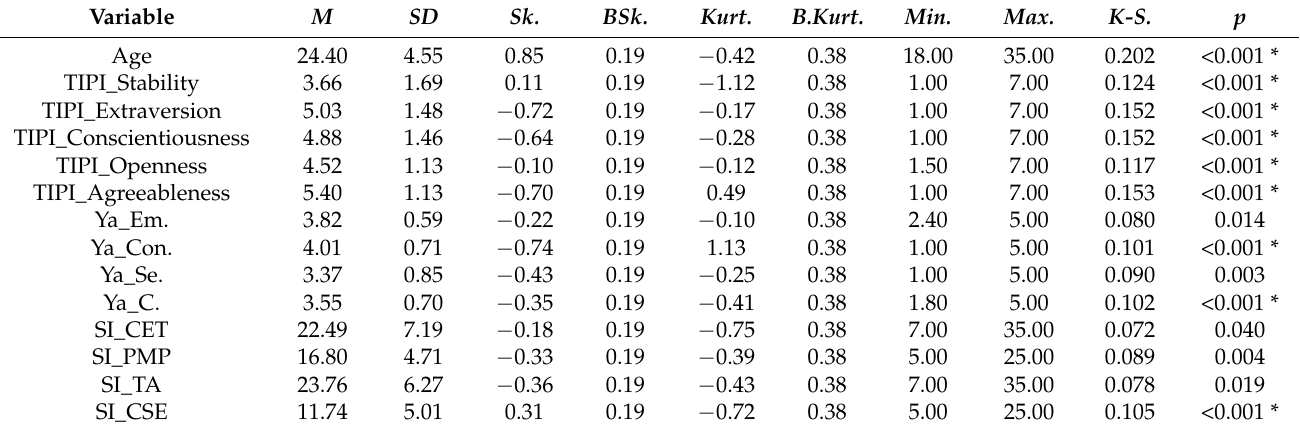
Table 1. Basic descriptive statistics of the measured variables with the Kolomogorov-Smirnov test.